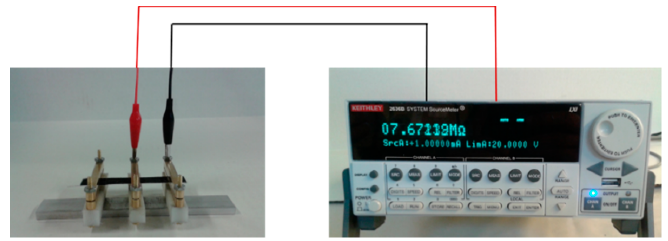
electrical conductivity ( σ ) was calculated using Equation (1).